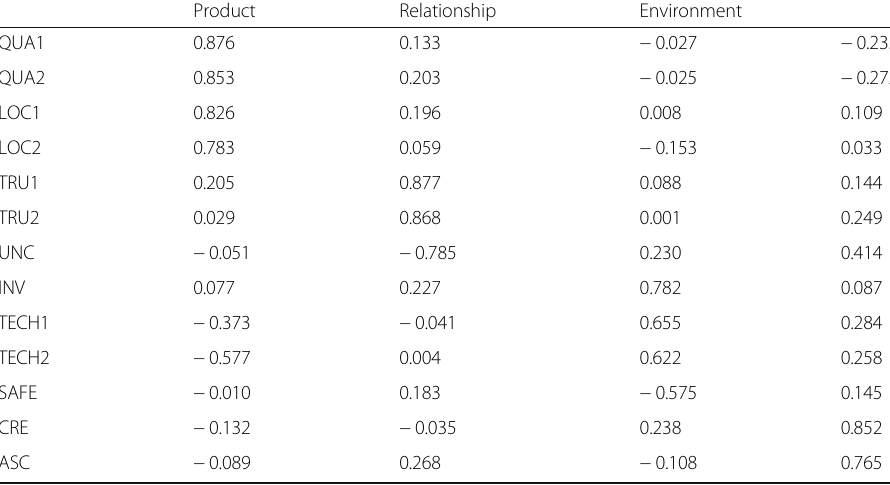
Table 5 Results of the exploratory factor analysis (EFA) Product